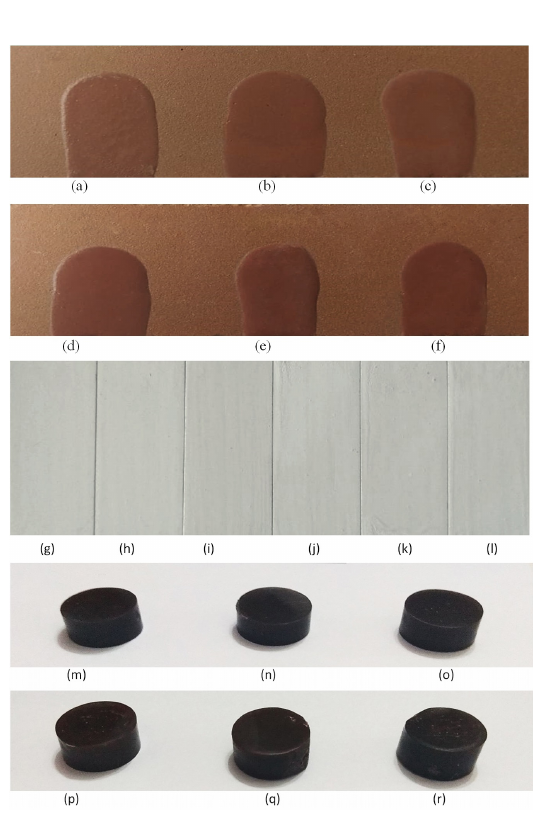
, a , (D) PAZR33 , (E) PAZR33 , and c a b , (H) PAZC33 , (I) PAZC33 , a b c , and (L) PAZR33 ; in the PMMA: b c , (O) PAZC33 , (P) PAZR33 , b c a . The a, b, or c indices in sample c